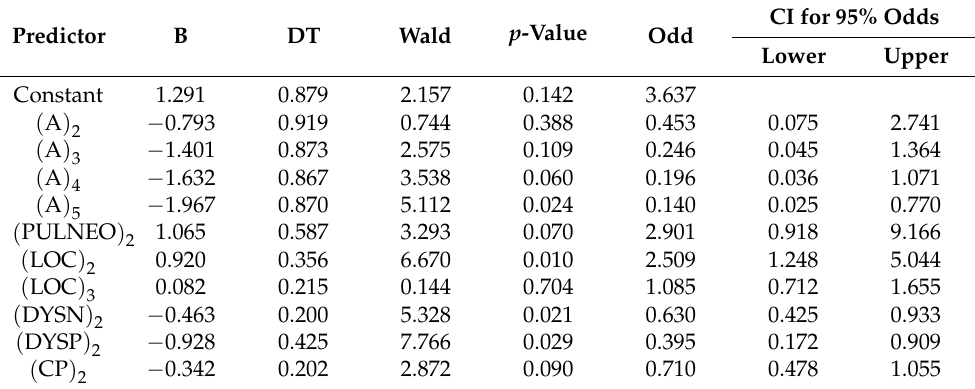
Table 2. Logit model for survival (clinical and epidemiological